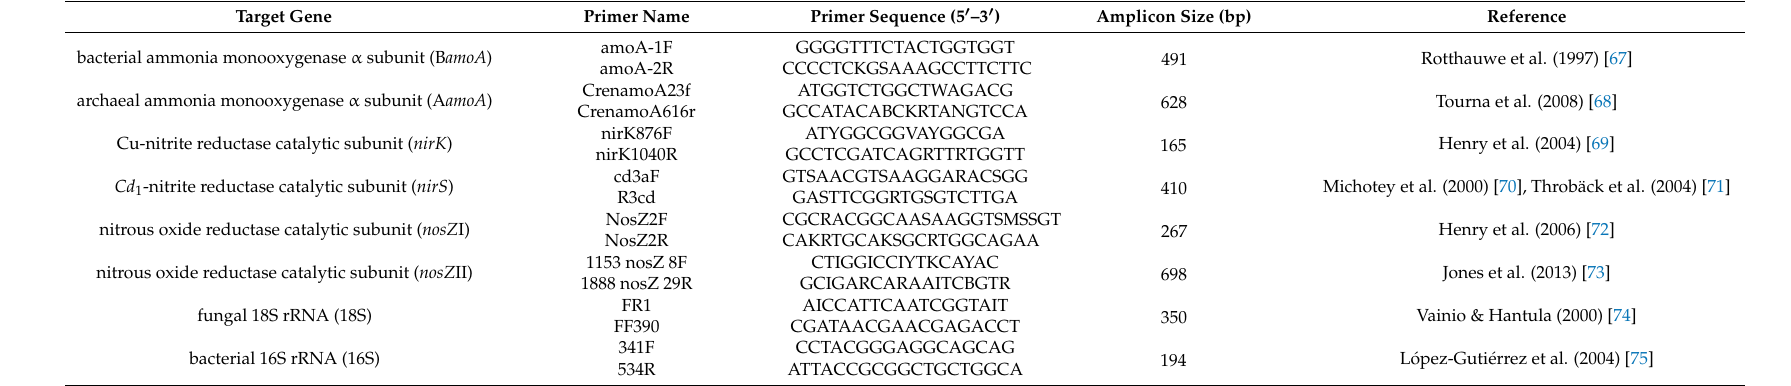
Table A3. Target genes, oligonucleotide primers and amplicon size.